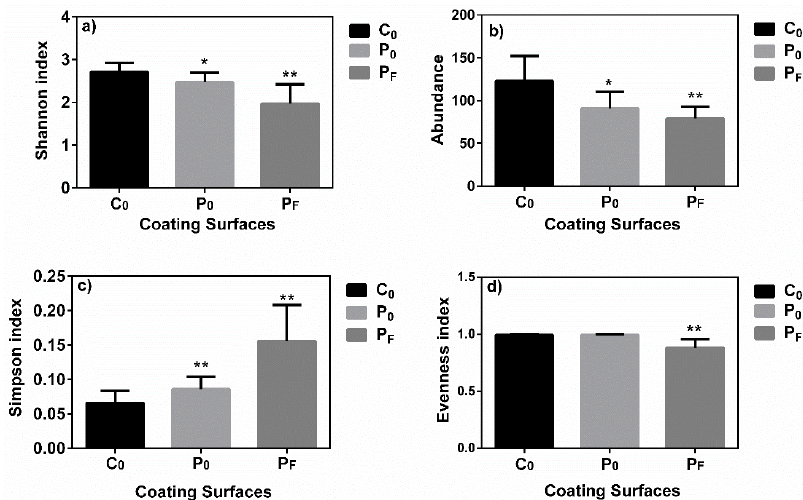
Figure 4. Comparison of the diversity indices of pioneer eukaryotic microbial communities colonized on the C 0 , P 0 and P F surfaces, including ( a ) Shannon diversity index, ( b ) Abundance, ( c ) Simpson index and ( d ) Evenness index. Error bars represent the standard deviation (SD) of the mean. One asterisk (*) represents significant difference (P < 0.05), whereas two asterisks (**) represent extremely significant difference (P < 0.01).